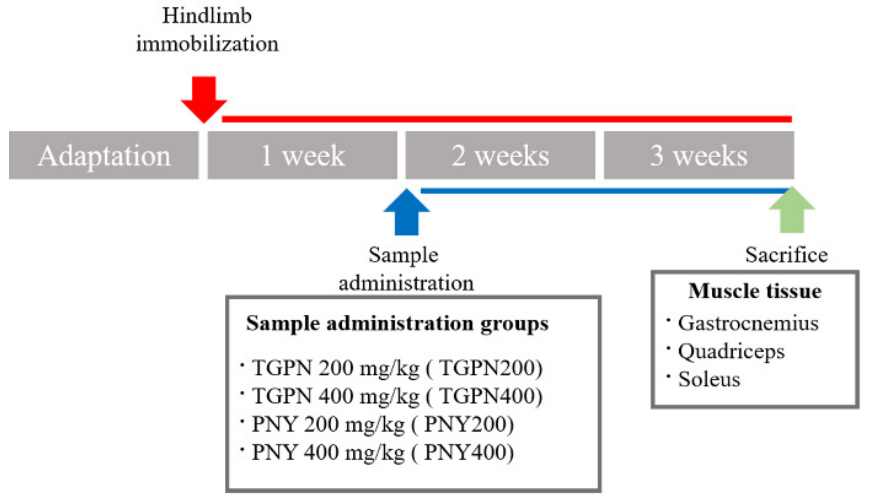
Figure 1. Animal experiment design.